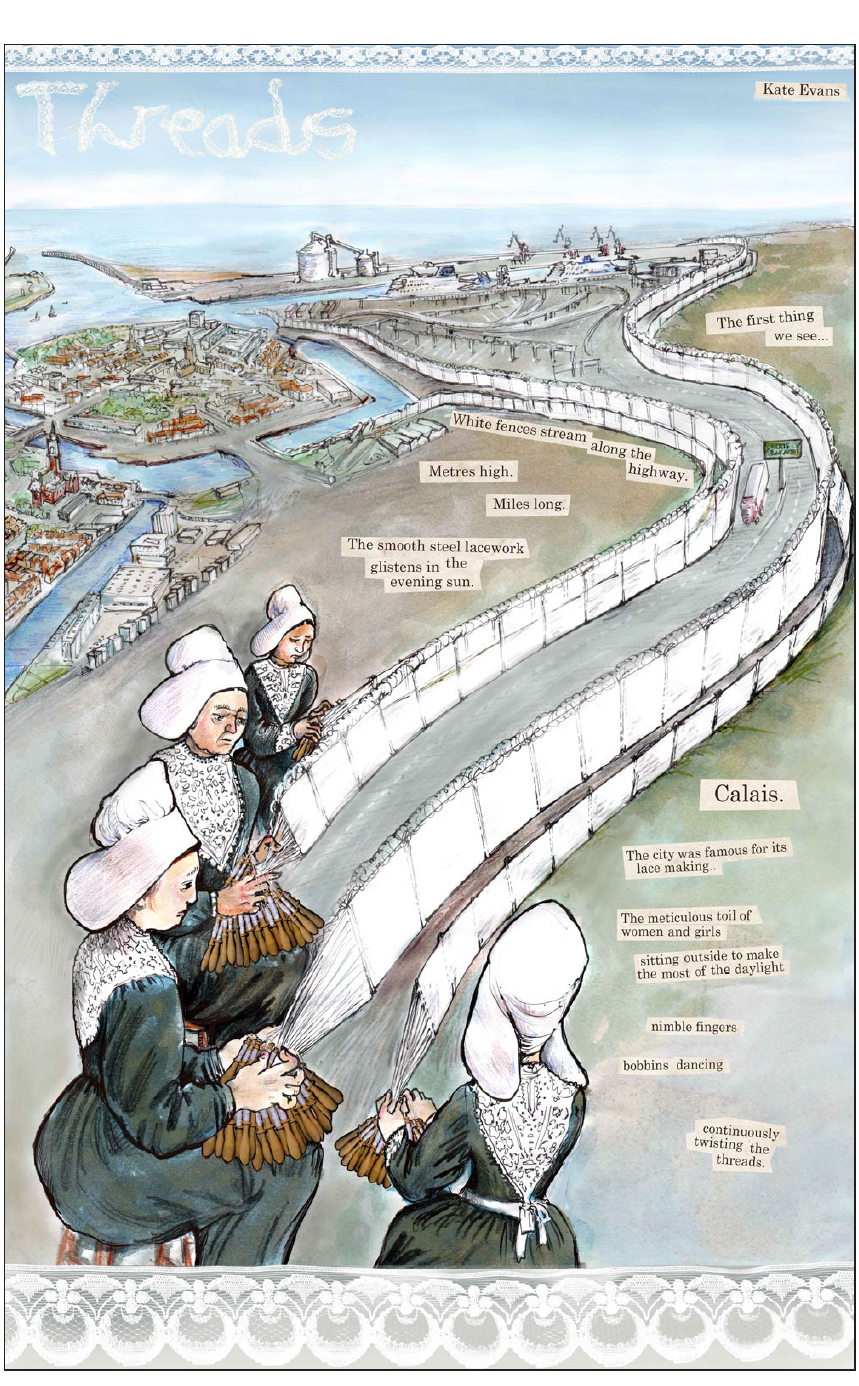
Figure 2: Excerpt from Evans, Kate (2017) Threads: From the Refugee Crisis (London & New York: Verso) © Kate